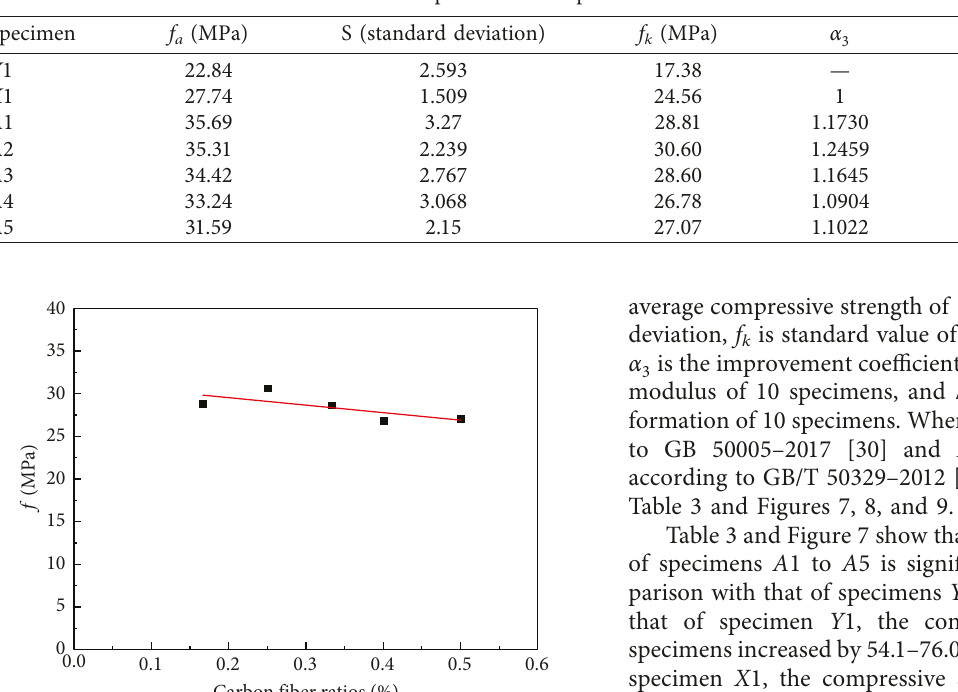
Figure 6: Failure mode of the specimens (a) A 5, (b) B 1, and (c) B 2. Table 3: Mechanical parameters of specimens with different carbon fiber ratios.